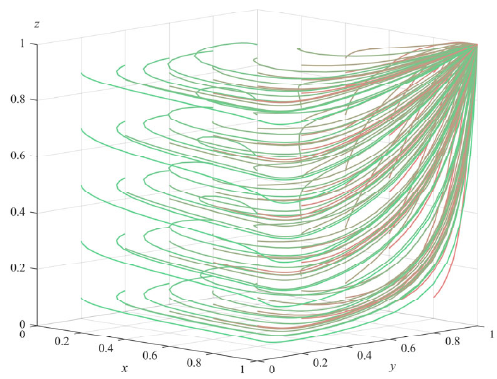
Figure 4. Simulation results of Proposition 4.